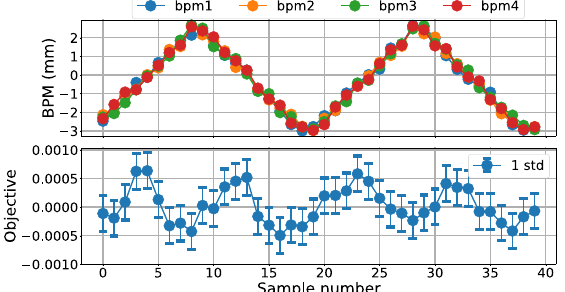
FIG. 6. 40 training points are sampled using Algorithm 2. The inputs step through the entire range (top) which helps to reveal a clear pattern of the outputs (bottom). As we can see, input positions around 0 potentially have higher